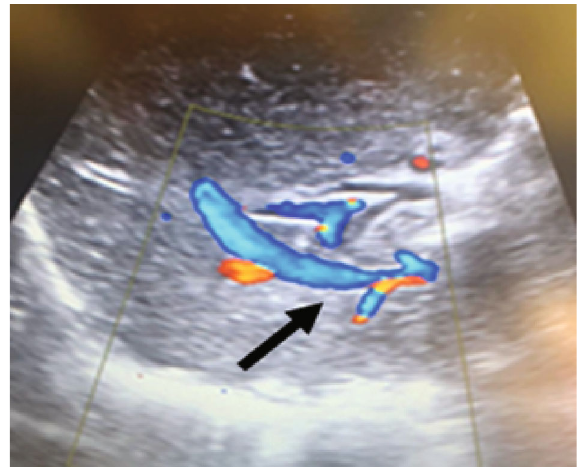
Figure 5: Intraoperative Doppler ultrasonography showing IRHV patency after resection, with hepatofugal fl ow (arrow).